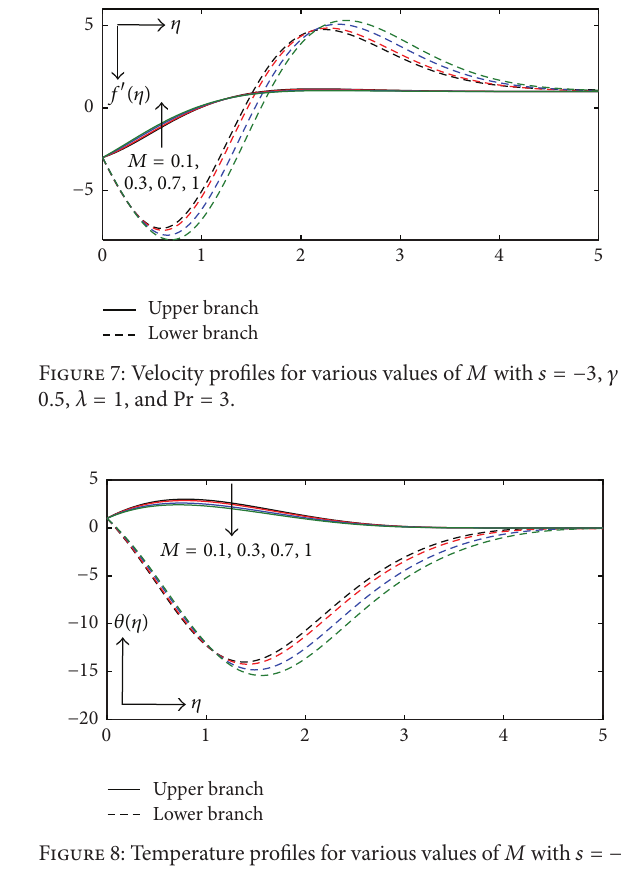
Figure 5: Variation of heat transfer at the surface with 𝑠 for various values of 𝛾 with 𝑀 = 0.5 , 𝜆 = 0.5 , and Pr = 1 .